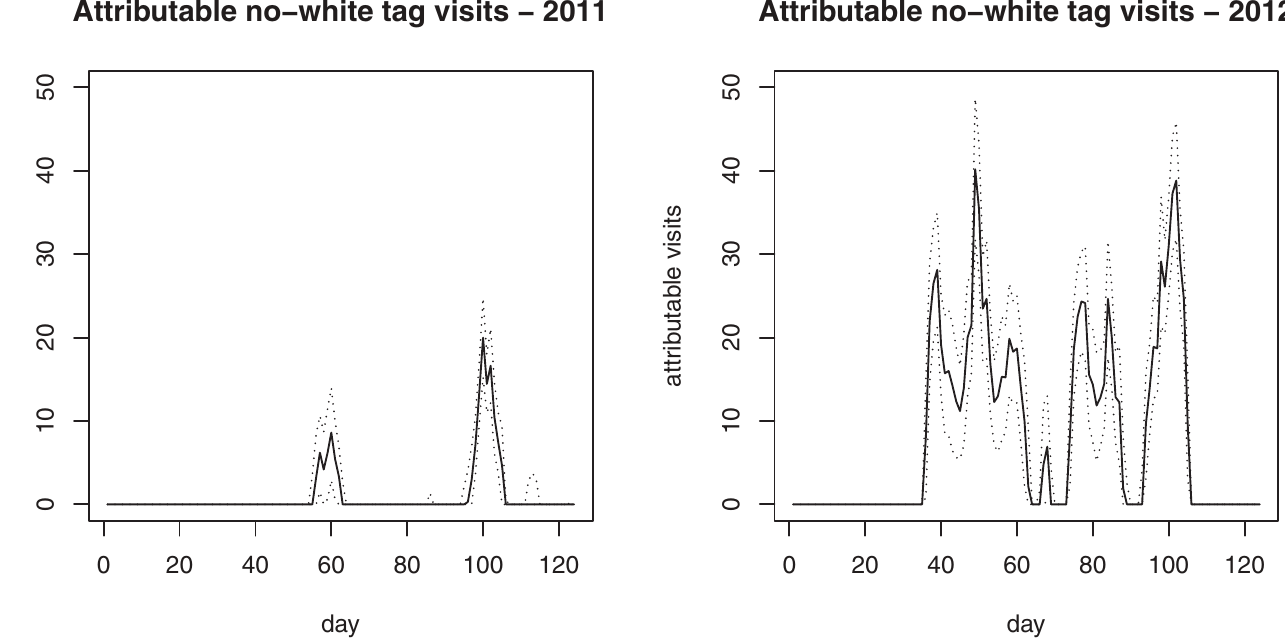
Fig 2. Daily mean apparent temperatures at lag 0 – 3 and expected daily numbers of attributable no-white tag visits during the study period. Daily mean apparent temperatures at lag 0 – 3 in 2011 and 2012 (upper panel); expected daily numbers of attributable no-white tag visits (for each day the median of the distribution is reported) in 2011 and 2012 (lower panel). Dotted lines represent the 90% confidence intervals (CI) for the estimated threshold (upper panel) and the 10th and 90th percentiles of the distribution of the daily number of attributable events. The values on the x axis refer to the calendar days within each warm season, from 1, representing May 15 th , to 122, representing September 15 th